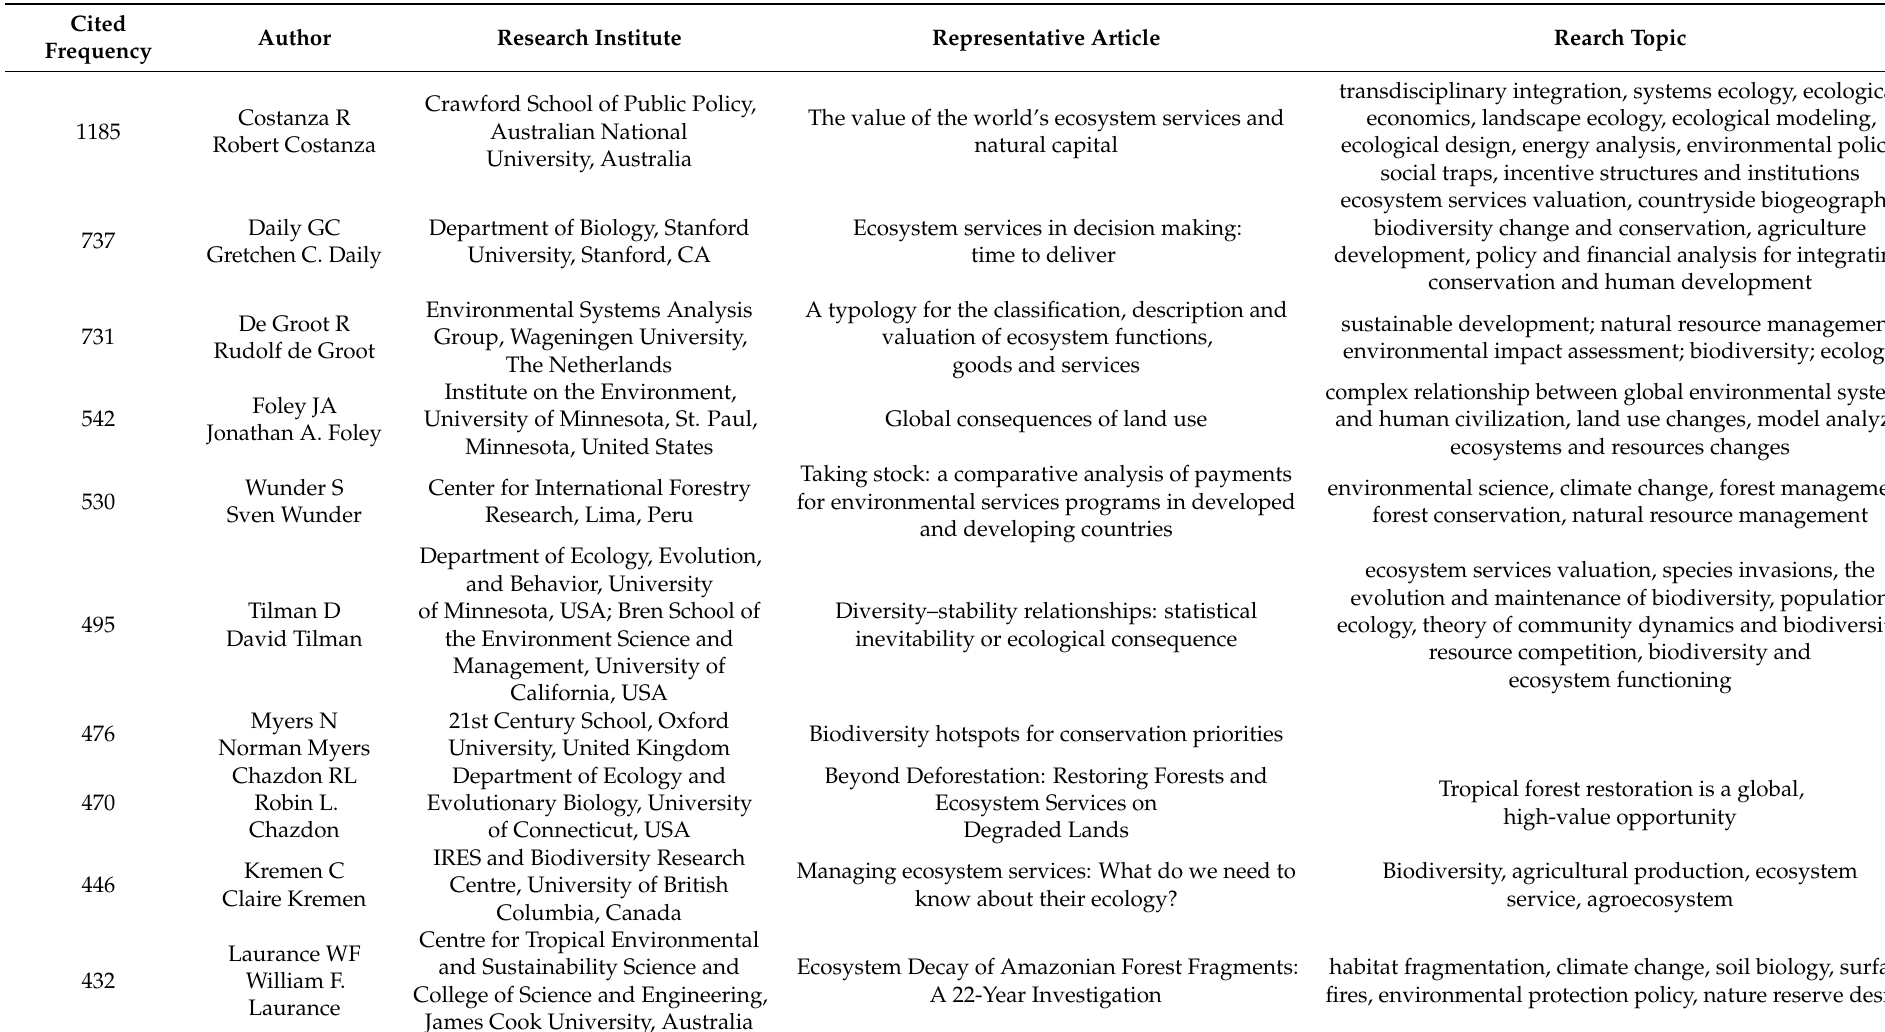
Table 1. The top 10 most cited authors in terms of the number of publications on FES-related